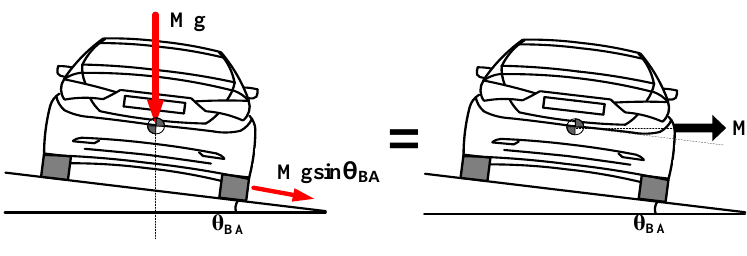
Figure 1. Centripetal force due to road bank angle .